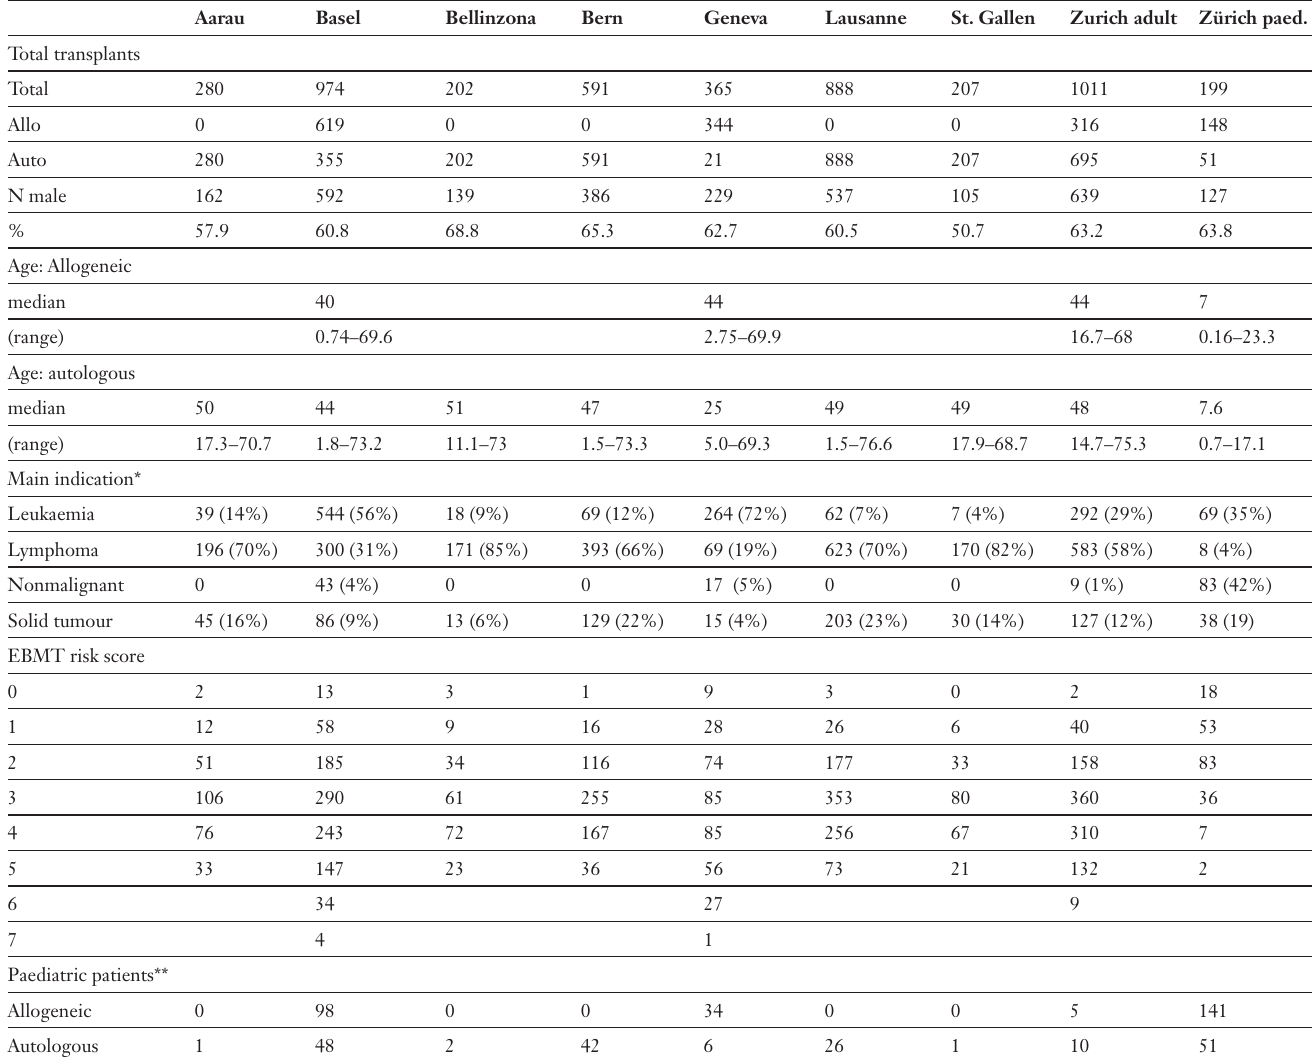
Main indications and HSCT characteristics by transplant